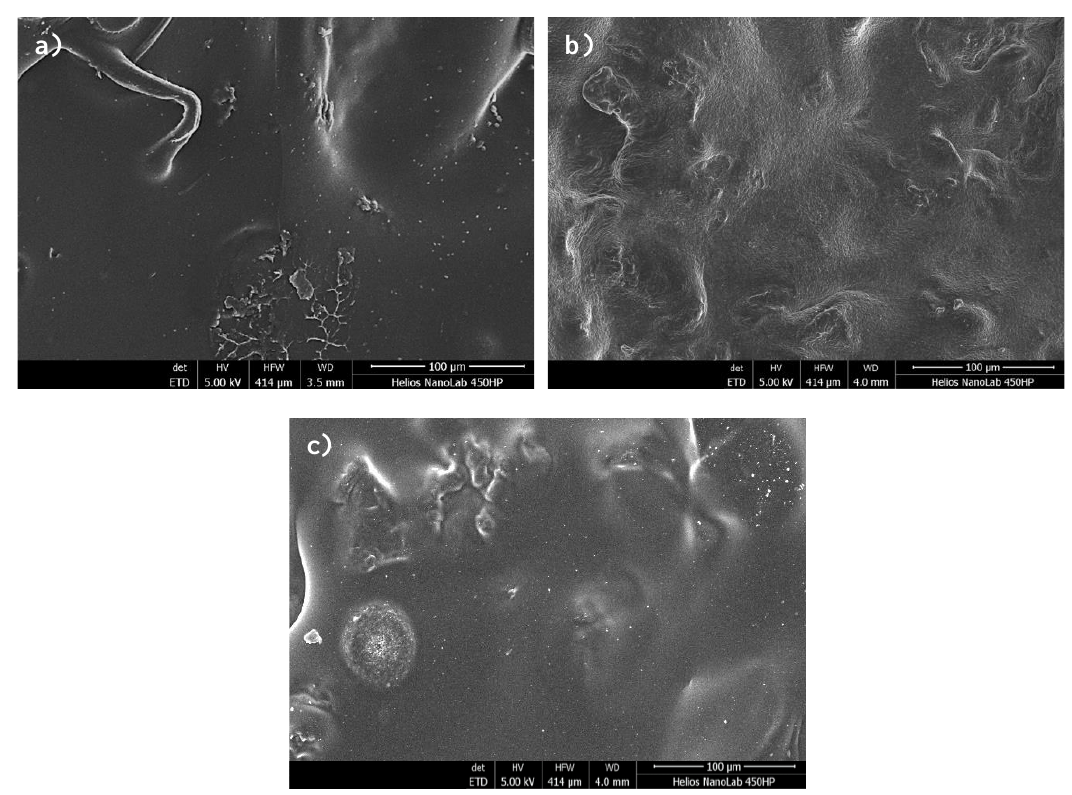
Figure 9. SEM images of unmodified hydrogel samples based on ( a ) Beetosan ® and ( b ) commercial chitosan and ( c ) sample modified with yellow tea extract (sample 23/3.2).